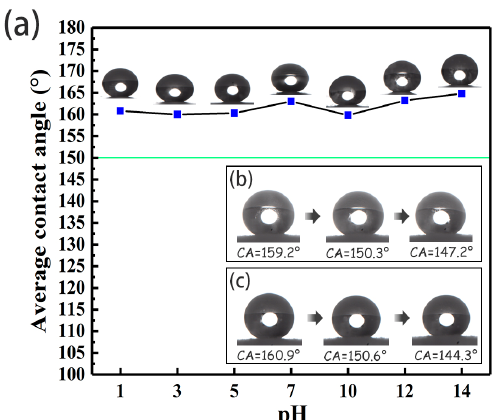
Figure 10. ( a ) The contact angle of water droplets with different pH values on the sample surface. ( b ) The change of the contact angle of water droplets with a pH of 14 over time. ( c ) The change of the contact angle of water droplets with a pH of 1 over time.